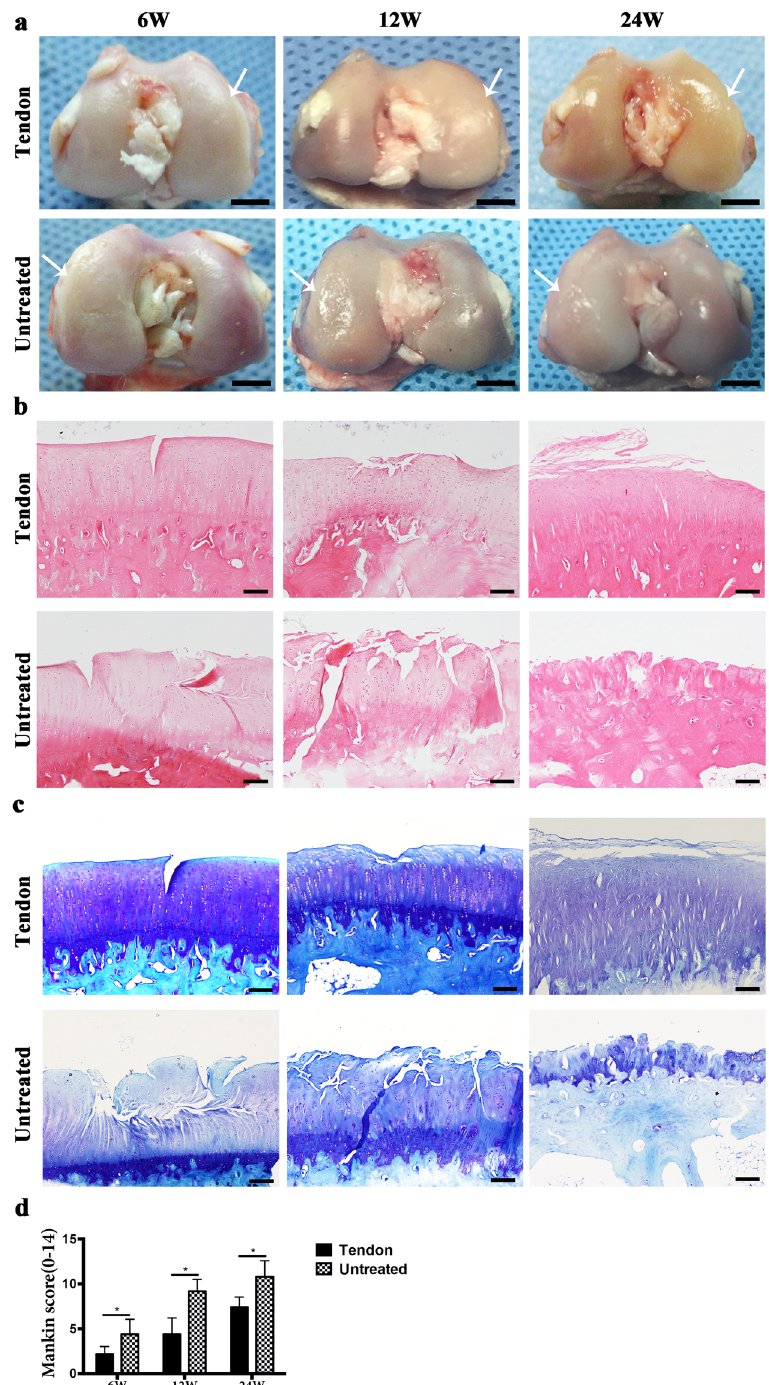
Figure 8. Macroscopic and histological analyses for articular cartilage at the medial femoral condyle. ( a ) Macroscopic features of femoral condyle cartilage. Arrows indicate medial femoral condyle. Scale bar = 5 mm. ( b ) HE staining of medial femoral condyle cartilage. Scale bar = 100 μ m. ( c ) TB staining of medial femoral condylar cartilage. Scale bar = 100 μ m. ( d ) Mankin score. (n = 5, * p <